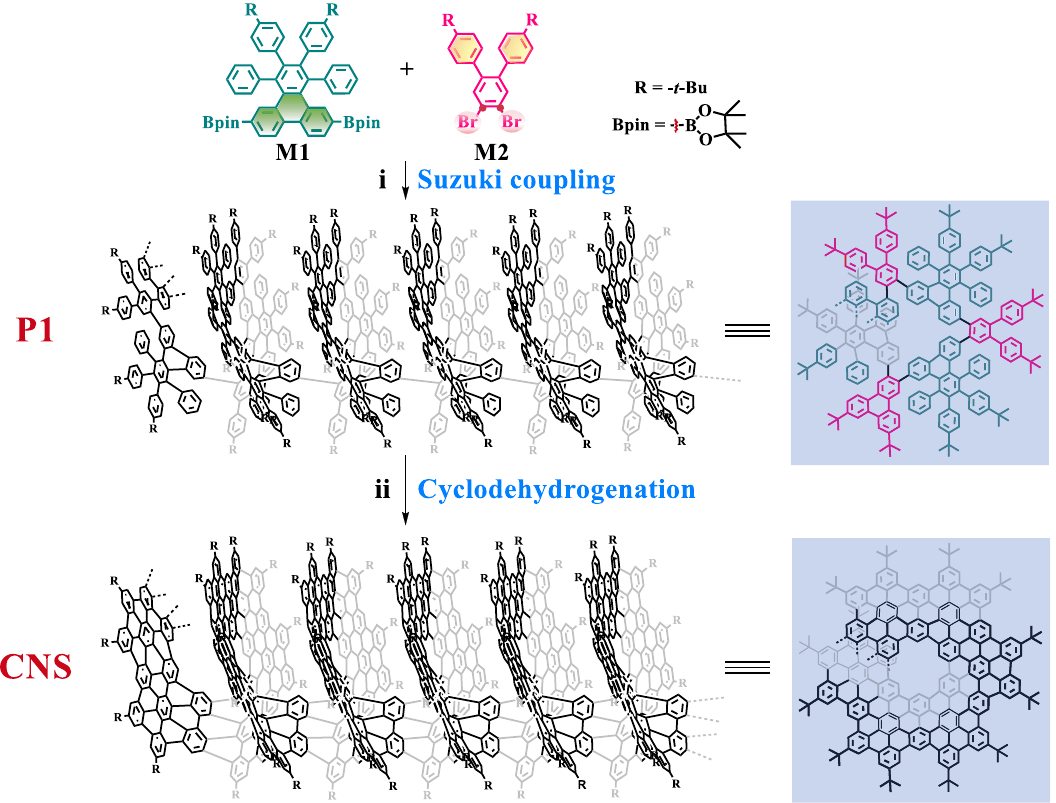
Fig. 2 Synthesis approach to the 3D fully π -extended curved single-stranded CNS. Reagents and conditions: (i) M1 (1.0 equiv.), M2 (1.0 equiv.), K 2 CO 3 (10 equiv.), Aliquat 336 (5 mol%), Pd(PPh 3 ) 4 (10 mol%), Ar, toluene/H 2 O ( v / v , 5:1), 110 °C, 5 days; (ii) P1 (1.0 equiv.), DDQ (14 equiv.), TfOH, Ar, anhydrous CH 2 Cl 2 , 0 °C, 15